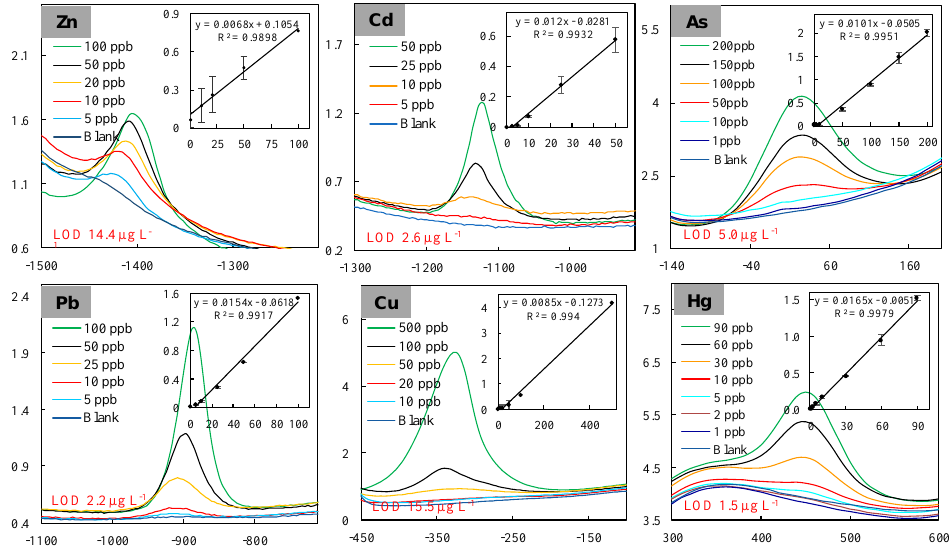
Figure 2. Individual electrochemical measurement of heavy metals in a standard solution using the “DEP-On-Go” system. DP voltammograms and corresponding calibration curves (inset) are shown for the detection of zinc, cadmium, lead and copper using a carbon DEP chip, and arsenic, and mercury using a gold DEP chip. The X -axis and Y -axis represent the potential (mV) and the current ( µ A), respectively. The X -axis and Y -axis in the insets represent the concentrations of metals ( µ g · L − 1 ) and calculated peak current heights ( µ A), respectively. The data are the averages of four to six independent experiments. LOD: limit of